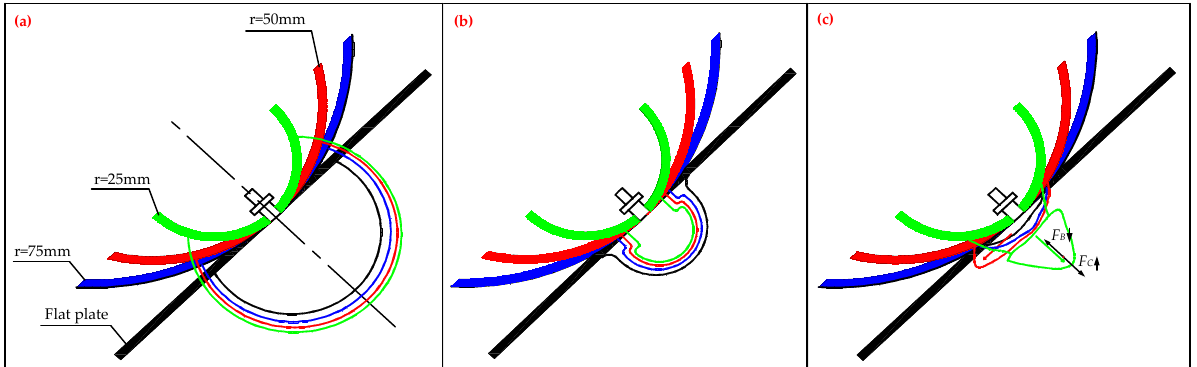
Figure 8. Bubble shape simulation diagram. ( a ) Type I bubbles expand in a hemispherical shape under different boundary conditions. ( b ) Type I bubbles shrink in a mushroom shape under different boundary conditions. ( c ) Type I bubble expansion form and force analysis in the second cycle.